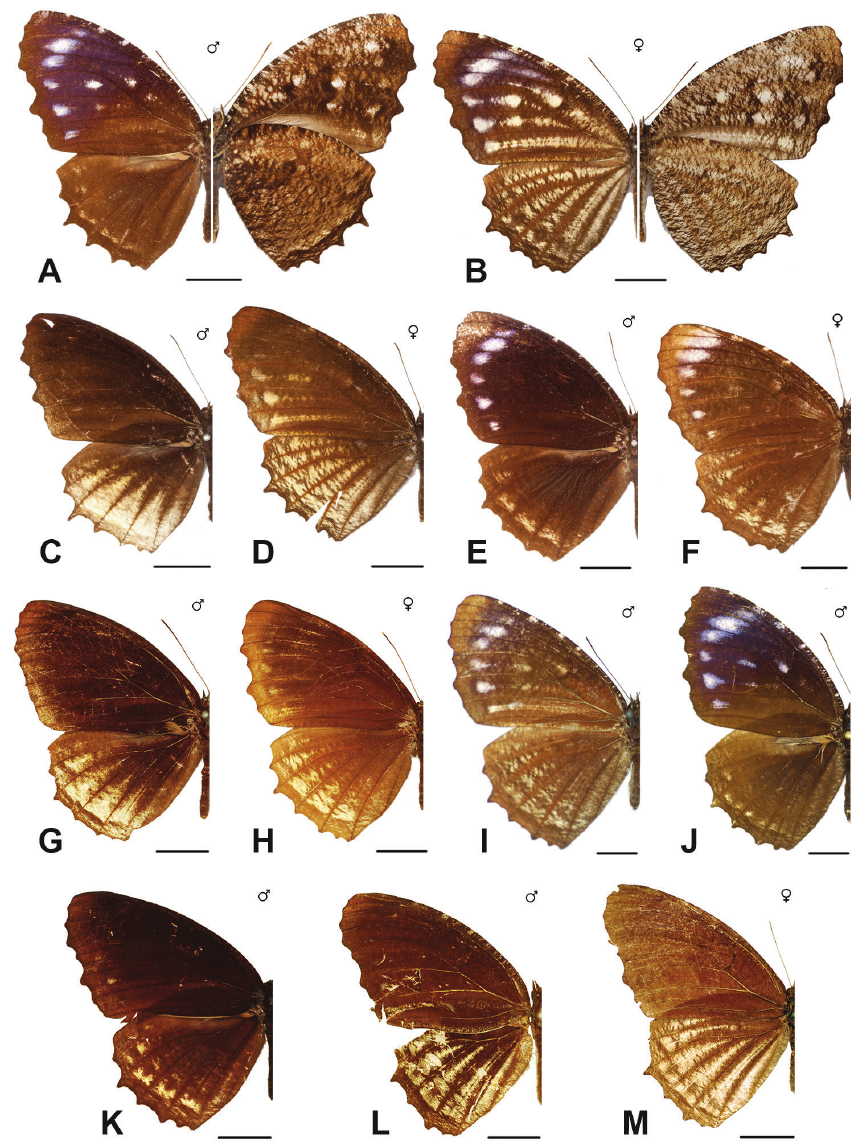
Figure 13. A casiphone casiphone ♂ D+V NHM Indonesia: Java B casiphone casiphone ♀ D+V NHM Indonesia: Java C casiphone kamara ♂ D NHM Indonesia: Java D casiphone kamara ♀ D NHM In- donesia: Java E casiphone praetextata ♂ D NHM Indonesia: West Nusa Tenggara, Lombok F casiphone praetextata ♀ D NHM Indonesia: West Nusa Tenggara, Lombok G casiphone praetextata (= kamara lom- bokiana ) ♂ D NHM Indonesia: West Nusa Tenggara, Lombok H casiphone praetextata (= kamara lom- bokiana ) ♀ D NHM Indonesia: West Nusa Tenggara, Lombok I casiphone praetextata (= kamara lomboki- ana ) ♀ D NHM Indonesia: West Nusa Tenggara, Lombok; Syntype of Elymnias kamara lombokiana J ca- siphone alumna ♂ D NHM Indonesia: East Java, Blitar K casiphone exclusa ♂ D NHM Indonesia: